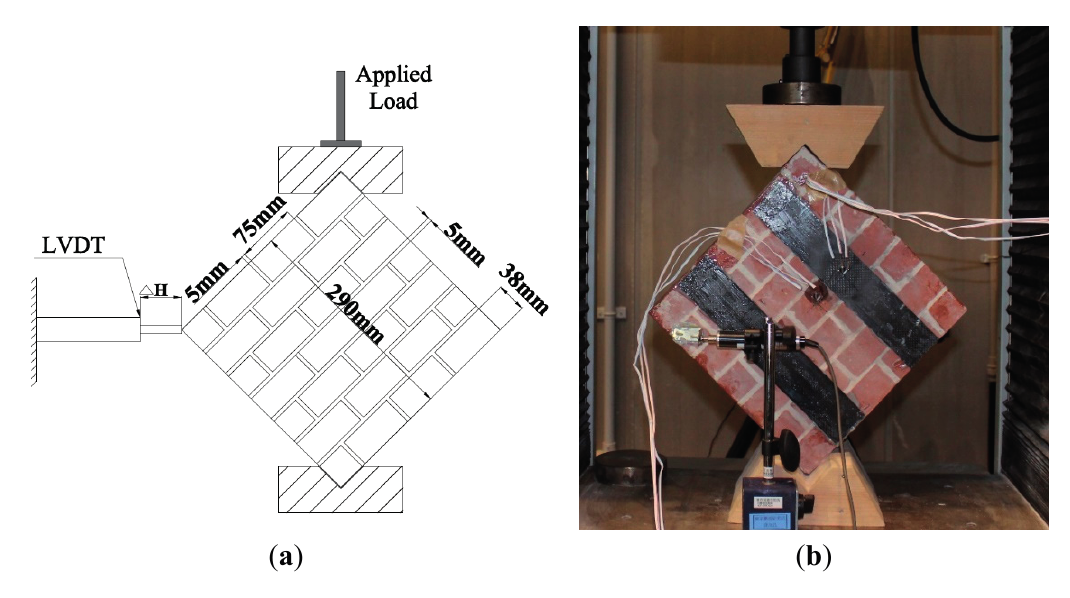
Figure 11. Test setup for diagonal compression test: ( a ) schematic and ( b )